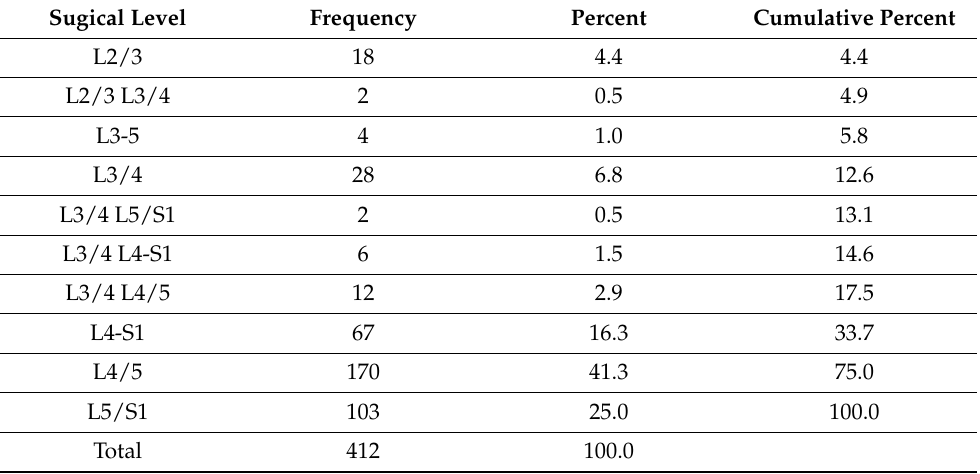
Table 1. Level distribution of surgical levels of patients treated with ELD, Laminectomy, and TLIF. Sugical Level Frequency Percent Cumulative